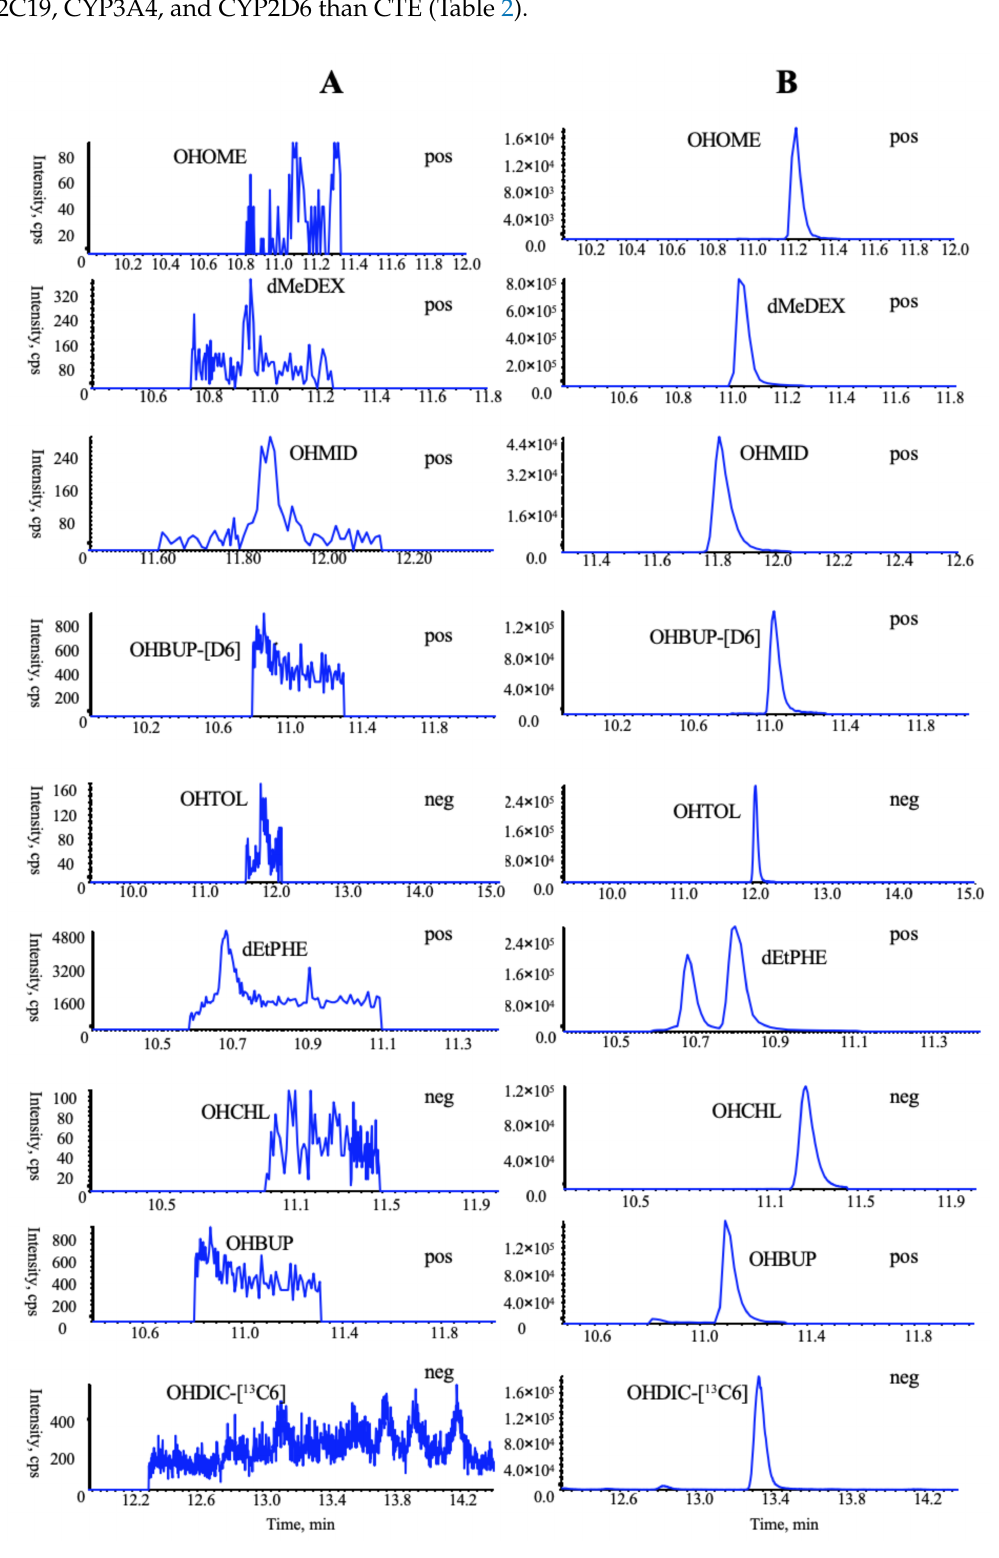
Figure 5. Representative MRM chromatograms of all probe metabolites and two ISs in the incubated rat microsomal sample with no substrate cocktails: ( A ) blank microsomal sample, ( B ) blank microsomal sample spiked with seven chemical standards and two ISs monitored in a polarity switching